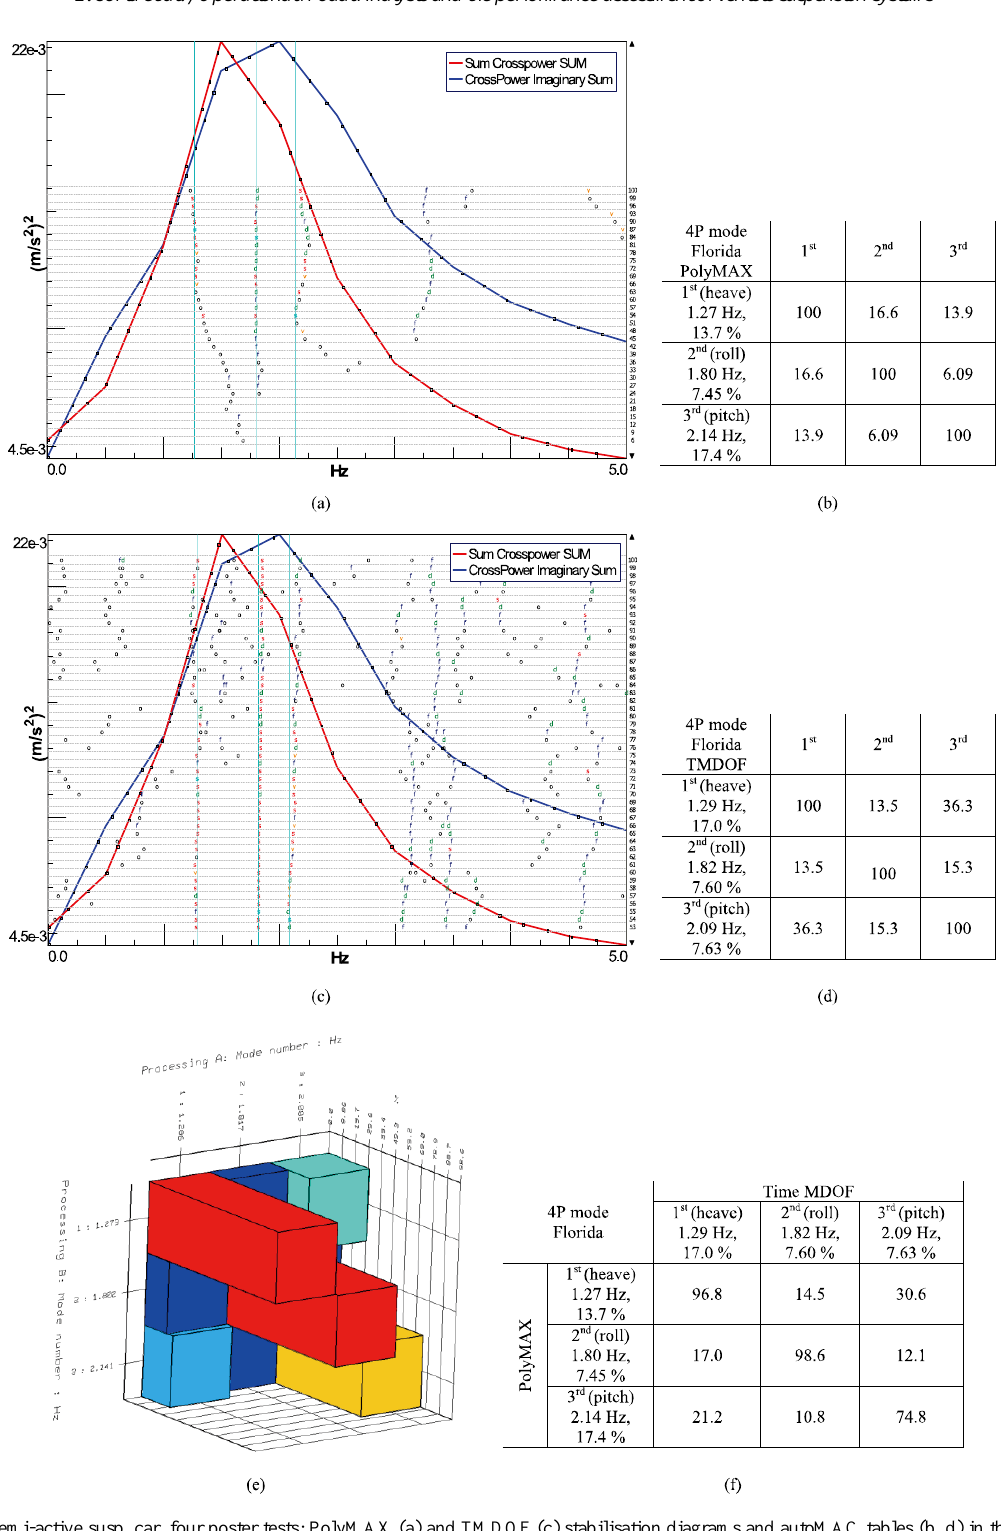
Fig. 6. Semi-active susp. car, four poster tests: PolyMAX (a) and TMDOF (c) stabilisation diagrams and autoMAC tables (b, d) in the Florida case. MAC matrix (e) and table (f) between these two mode set